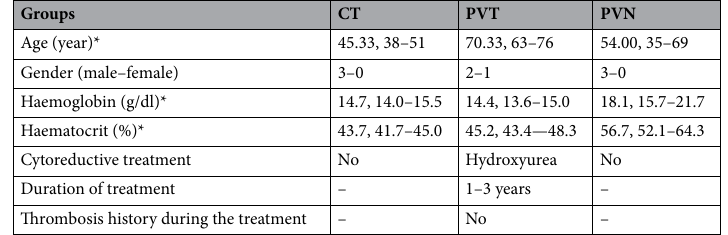
Table 1. Detailed information of volunteers included in each group (n = 3 for each group). *Mean, range of three